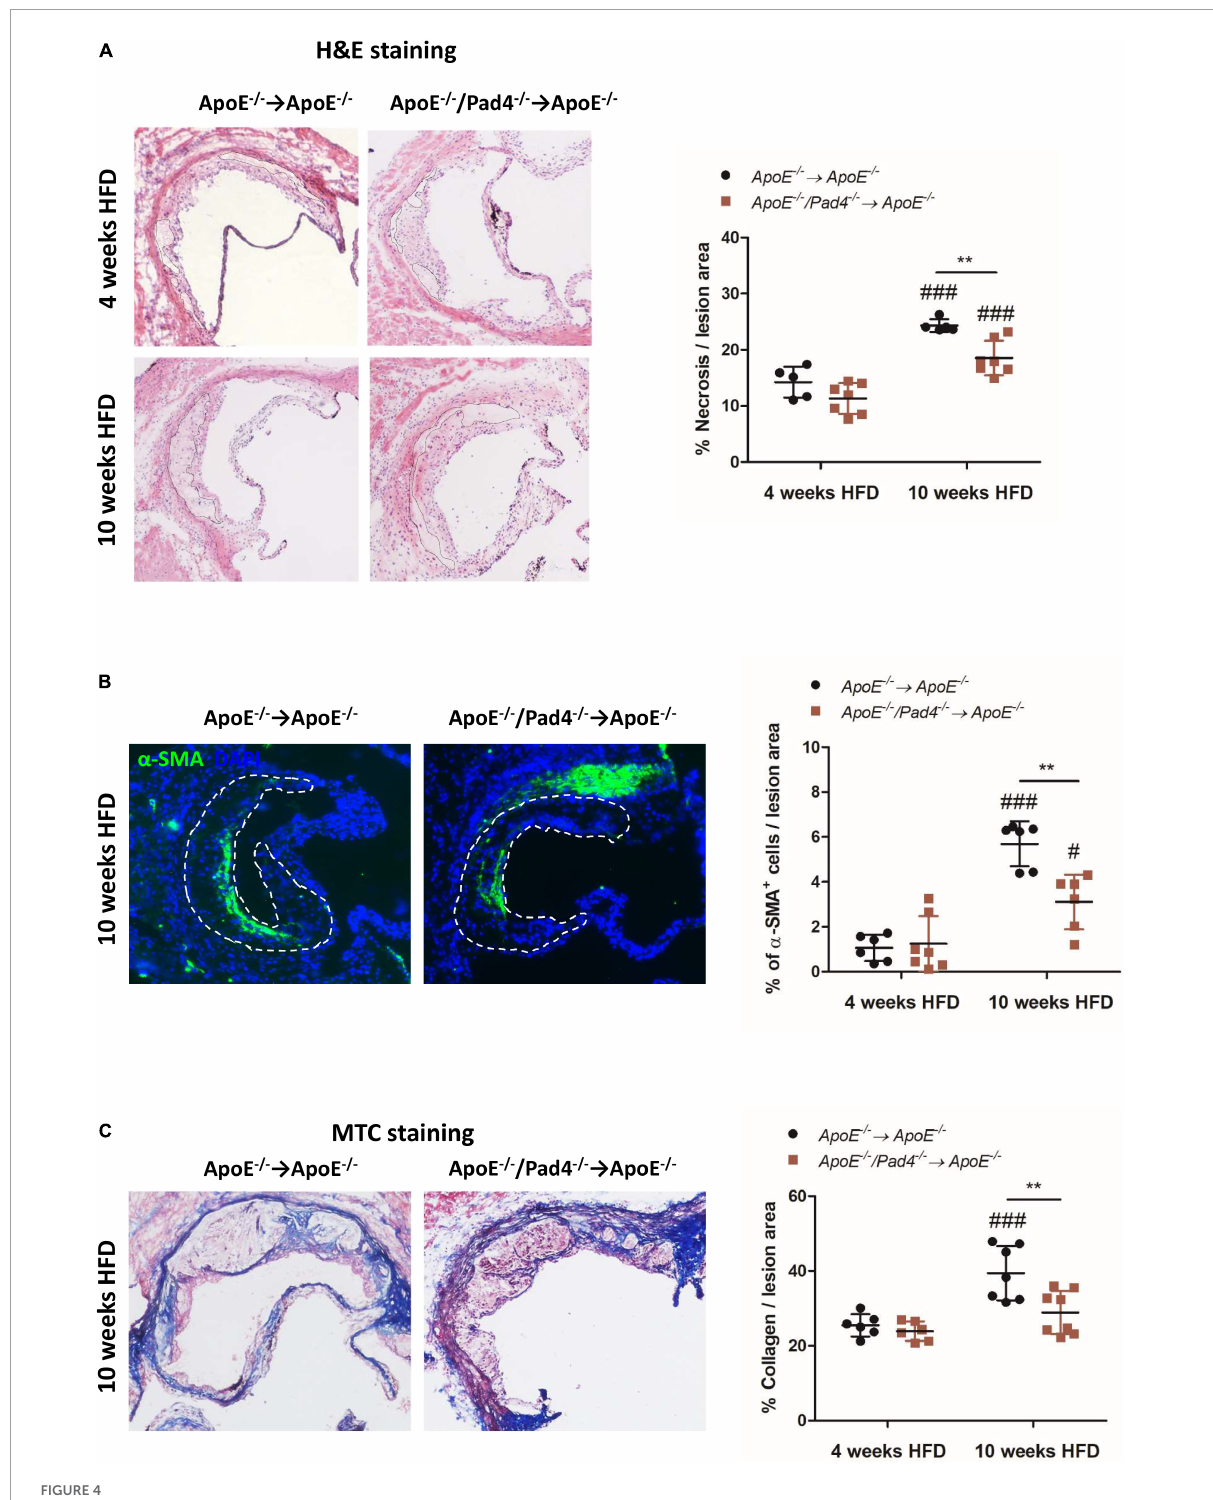
FIGURE4 PAD4 deficiency in bone marrow cells results in increased stability of atherosclerotic lesions. (A) Quantification of necrotic core area in H&E-stained aortic root sections of mice fed a high-fat diet (HFD) for 4 or 10 weeks, respectively. n = 5–7/group. (B) Quantification of α -SMA-positive area (smooth muscle cells) in atherosclerotic lesions of aortic root. Representative images are shown. n = 6–7/group. (C) Masson’s Trichrome staining of aortic root sections for collagen quantification. Representative images for each experimental group are depicted. n = 6–8/group. # p < 0.05, ### p < 0.001 vs. 4 weeks HFD, ** p <